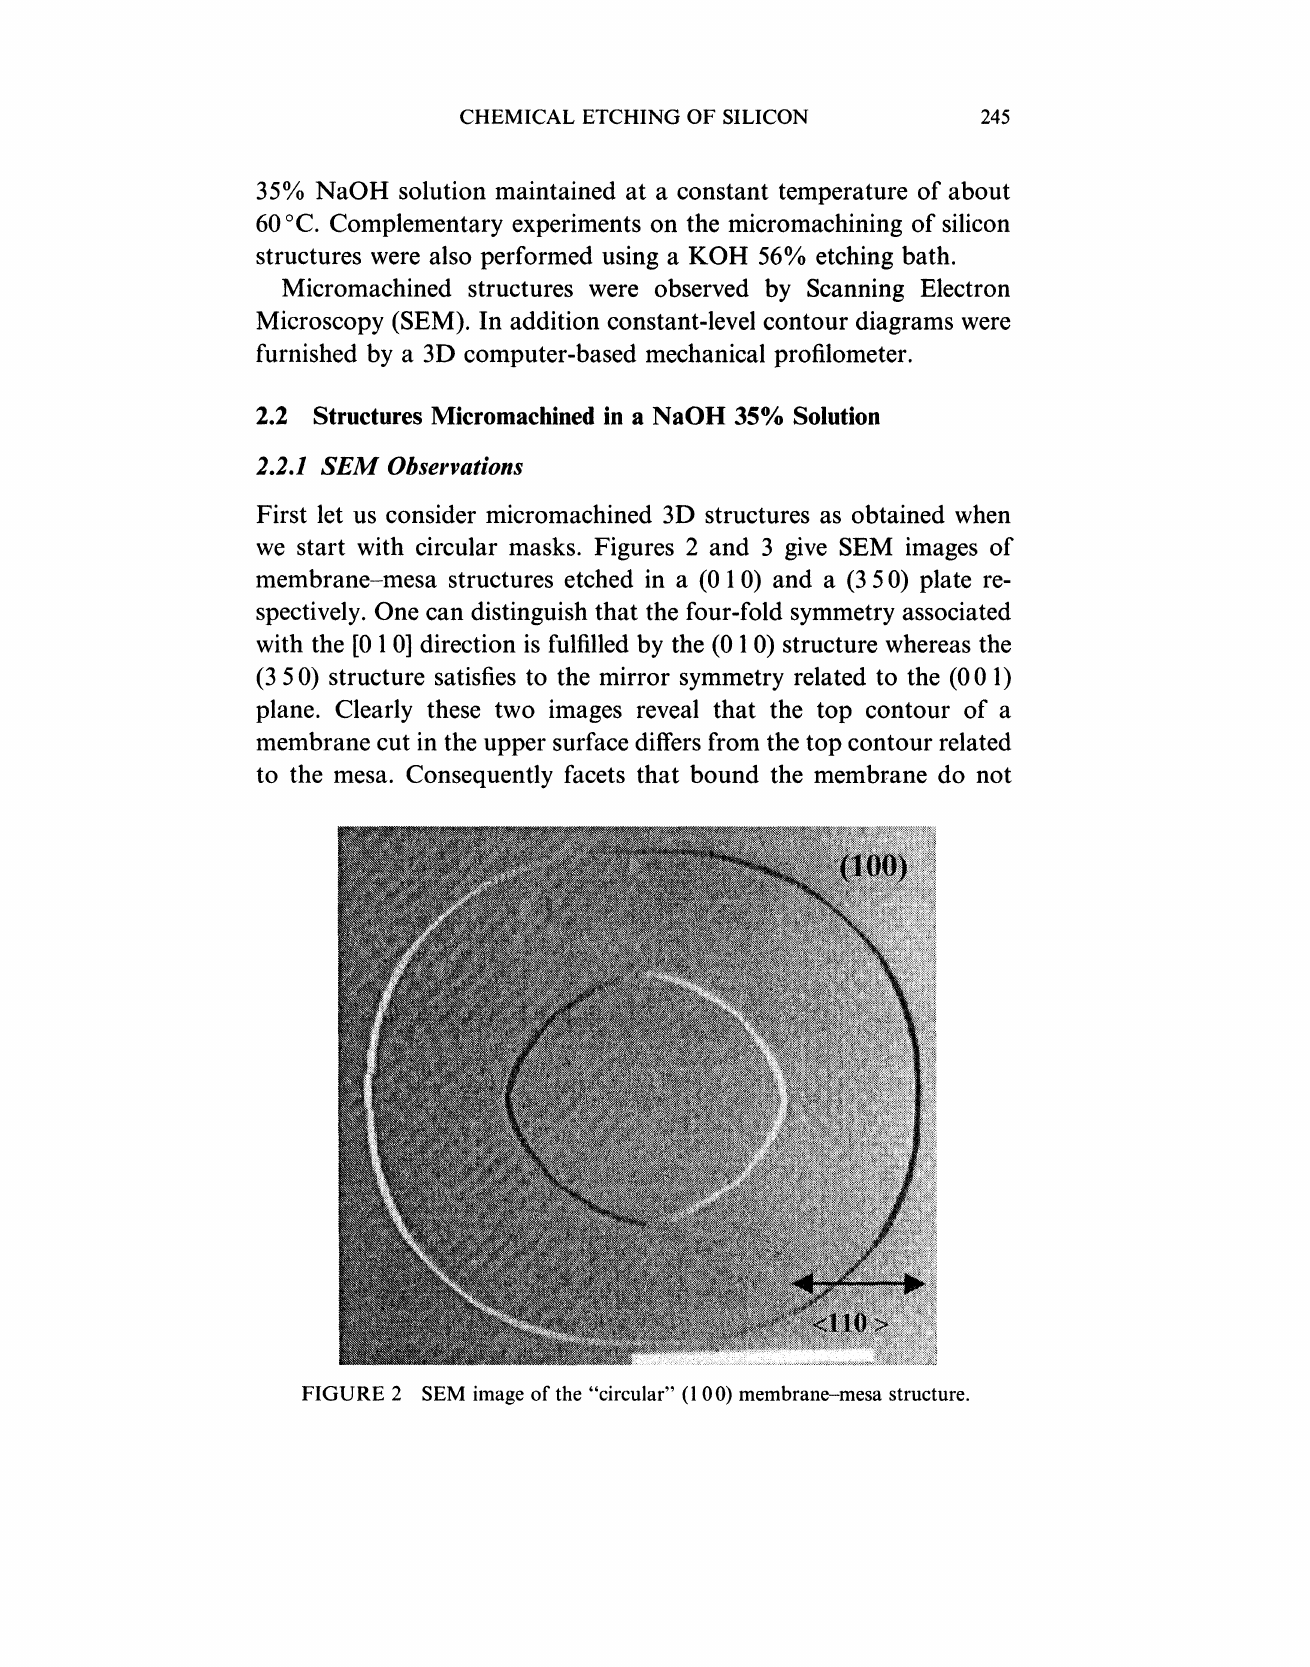
FIGURE 2 SEM image of the "circular" (100) membrane-mesa